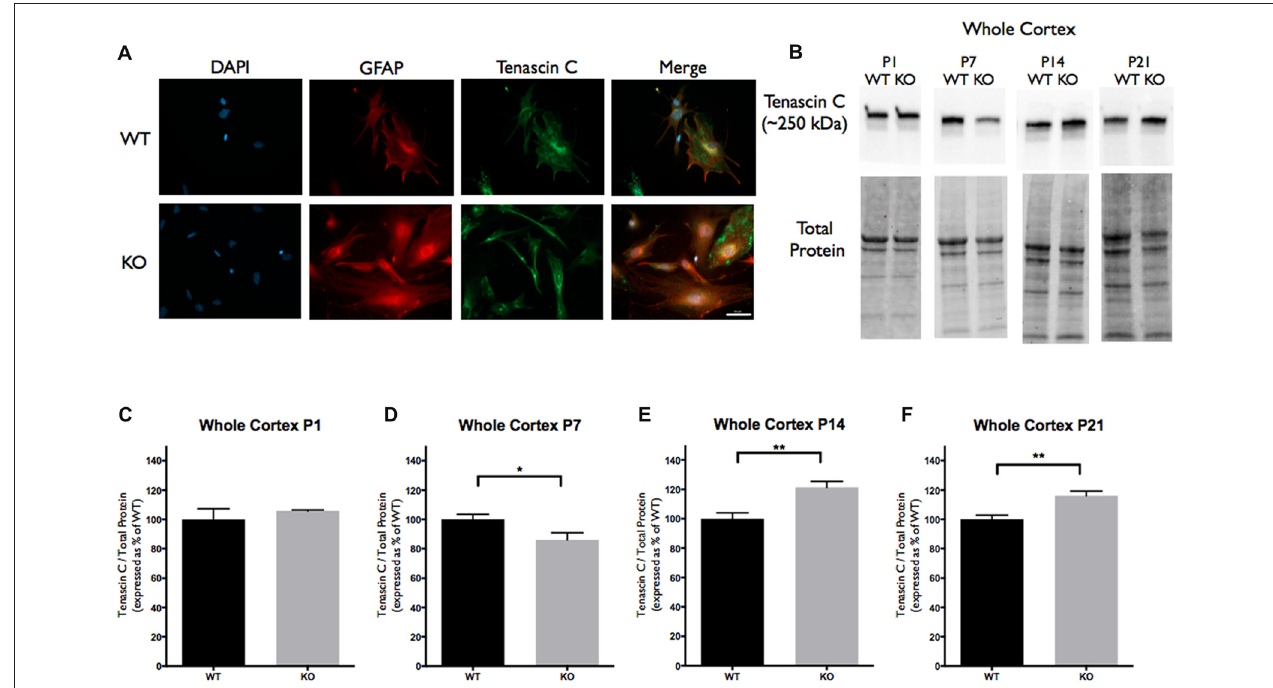
FIGURE 1 | Tenascin C (TNC) expression is significantly altered at postnatal period P7–P21 in the cortex of Fragile X Mental Retardation 1 ( FMR1 ) knockout (KO) mice. (A) Cultured cortical astrocytes co-labeled with anti-glial fibrillary acidic protein (GFAP; red), 4’,6-diamidino-2-Phenylindole (DAPI; blue) and anti-TNC (green) after 3 days in vitro . Images were obtained using a 40 × objective with a Zeiss Axioimager M2. Scale bars = 50 µ m. (B) Western blots showing TNC expression ( ∼ 250 kDa) in cortical samples containing 30 µ g of protein from P1, P7, P14 and P21 wild-type (WT) and FMR1 KO mice. Corresponding total protein was used as a loading control. (C–F) Cortical expression of TNC in WT (black; n = 8) and FMR1 KO (gray; n = 8) mice at P1 (six males and two females), P7 (five males and three females), P14 (six males and two females) and P21 (eight males and zero female). Representative bands were normalized to the total protein and expressed as a percentage of the average TNC in the WT group. Statistical differences denoted with a single asterisk, P < 0.05 and with a double asterisk, P <